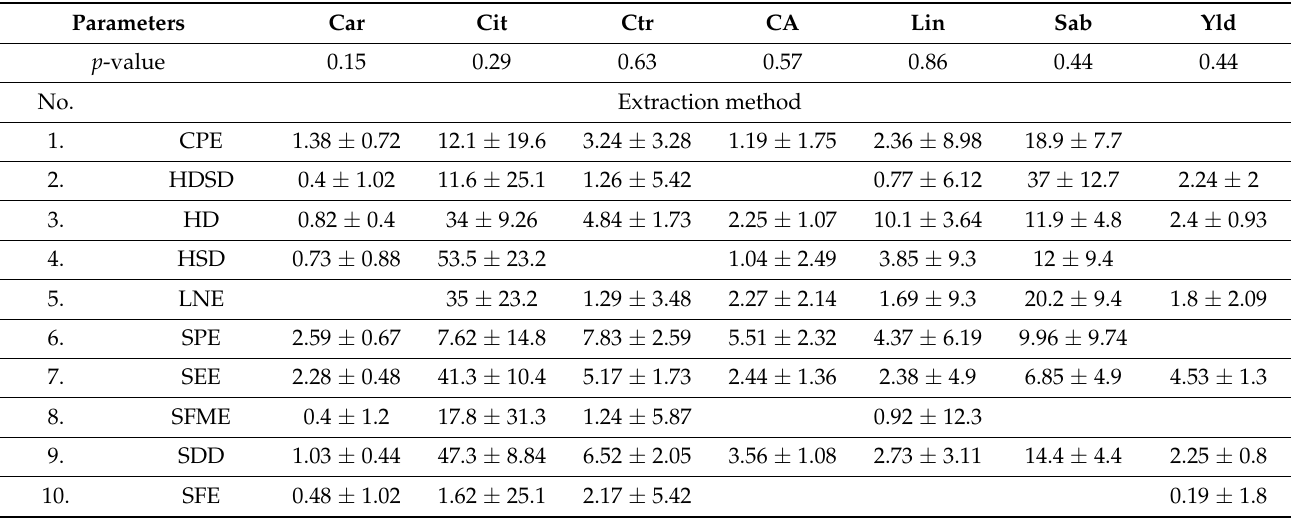
Table 7. Meta-analysis of yield and main components of kaffir lime essential oil in response to extraction method (mean ± standard